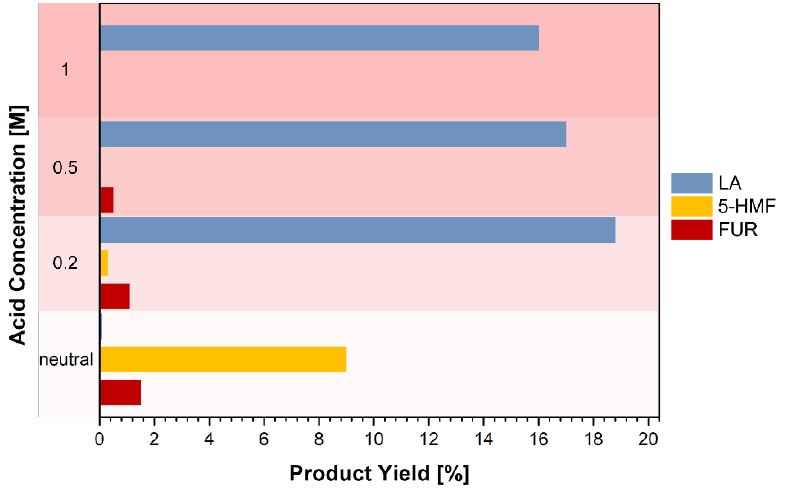
Figure 6. Effect of acid conditions on the production of furfural (FU), 5-hydroxymethylfurfural (5- HMF) and levulinic acid (LA) (Reaction conditions: 20 g of OPW; 20 mL solution of H 2 SO 4 (from 0,1 to 1,0 M) in H 2 O; temperature: 180 °C; time: 60 min; autogenous pressure; stirring: 600 rpm).